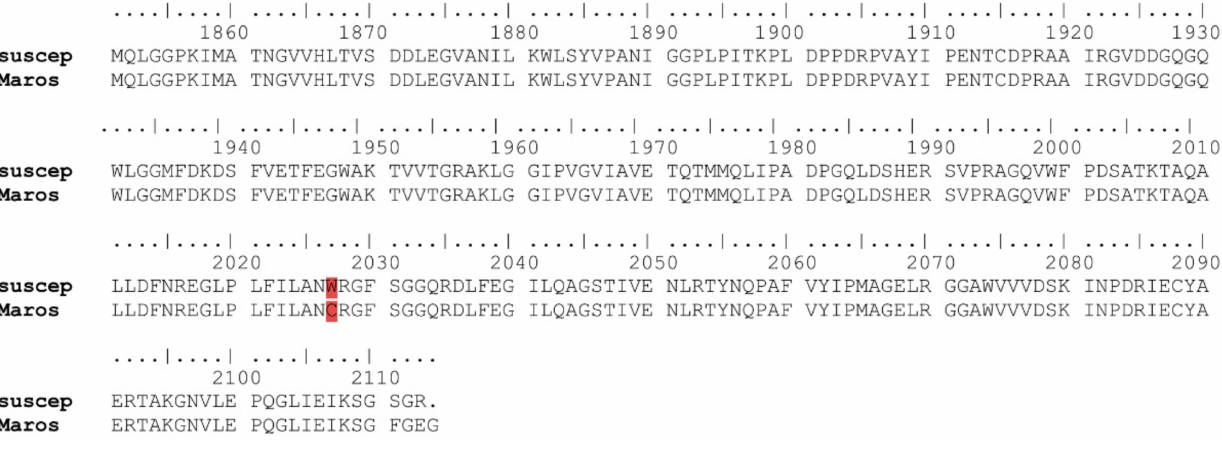
Figure 3. Alignment of deduced amino acid sequences of ACCase gene (red: amino acid substitution in the Maros biotype that change compared to susceptible